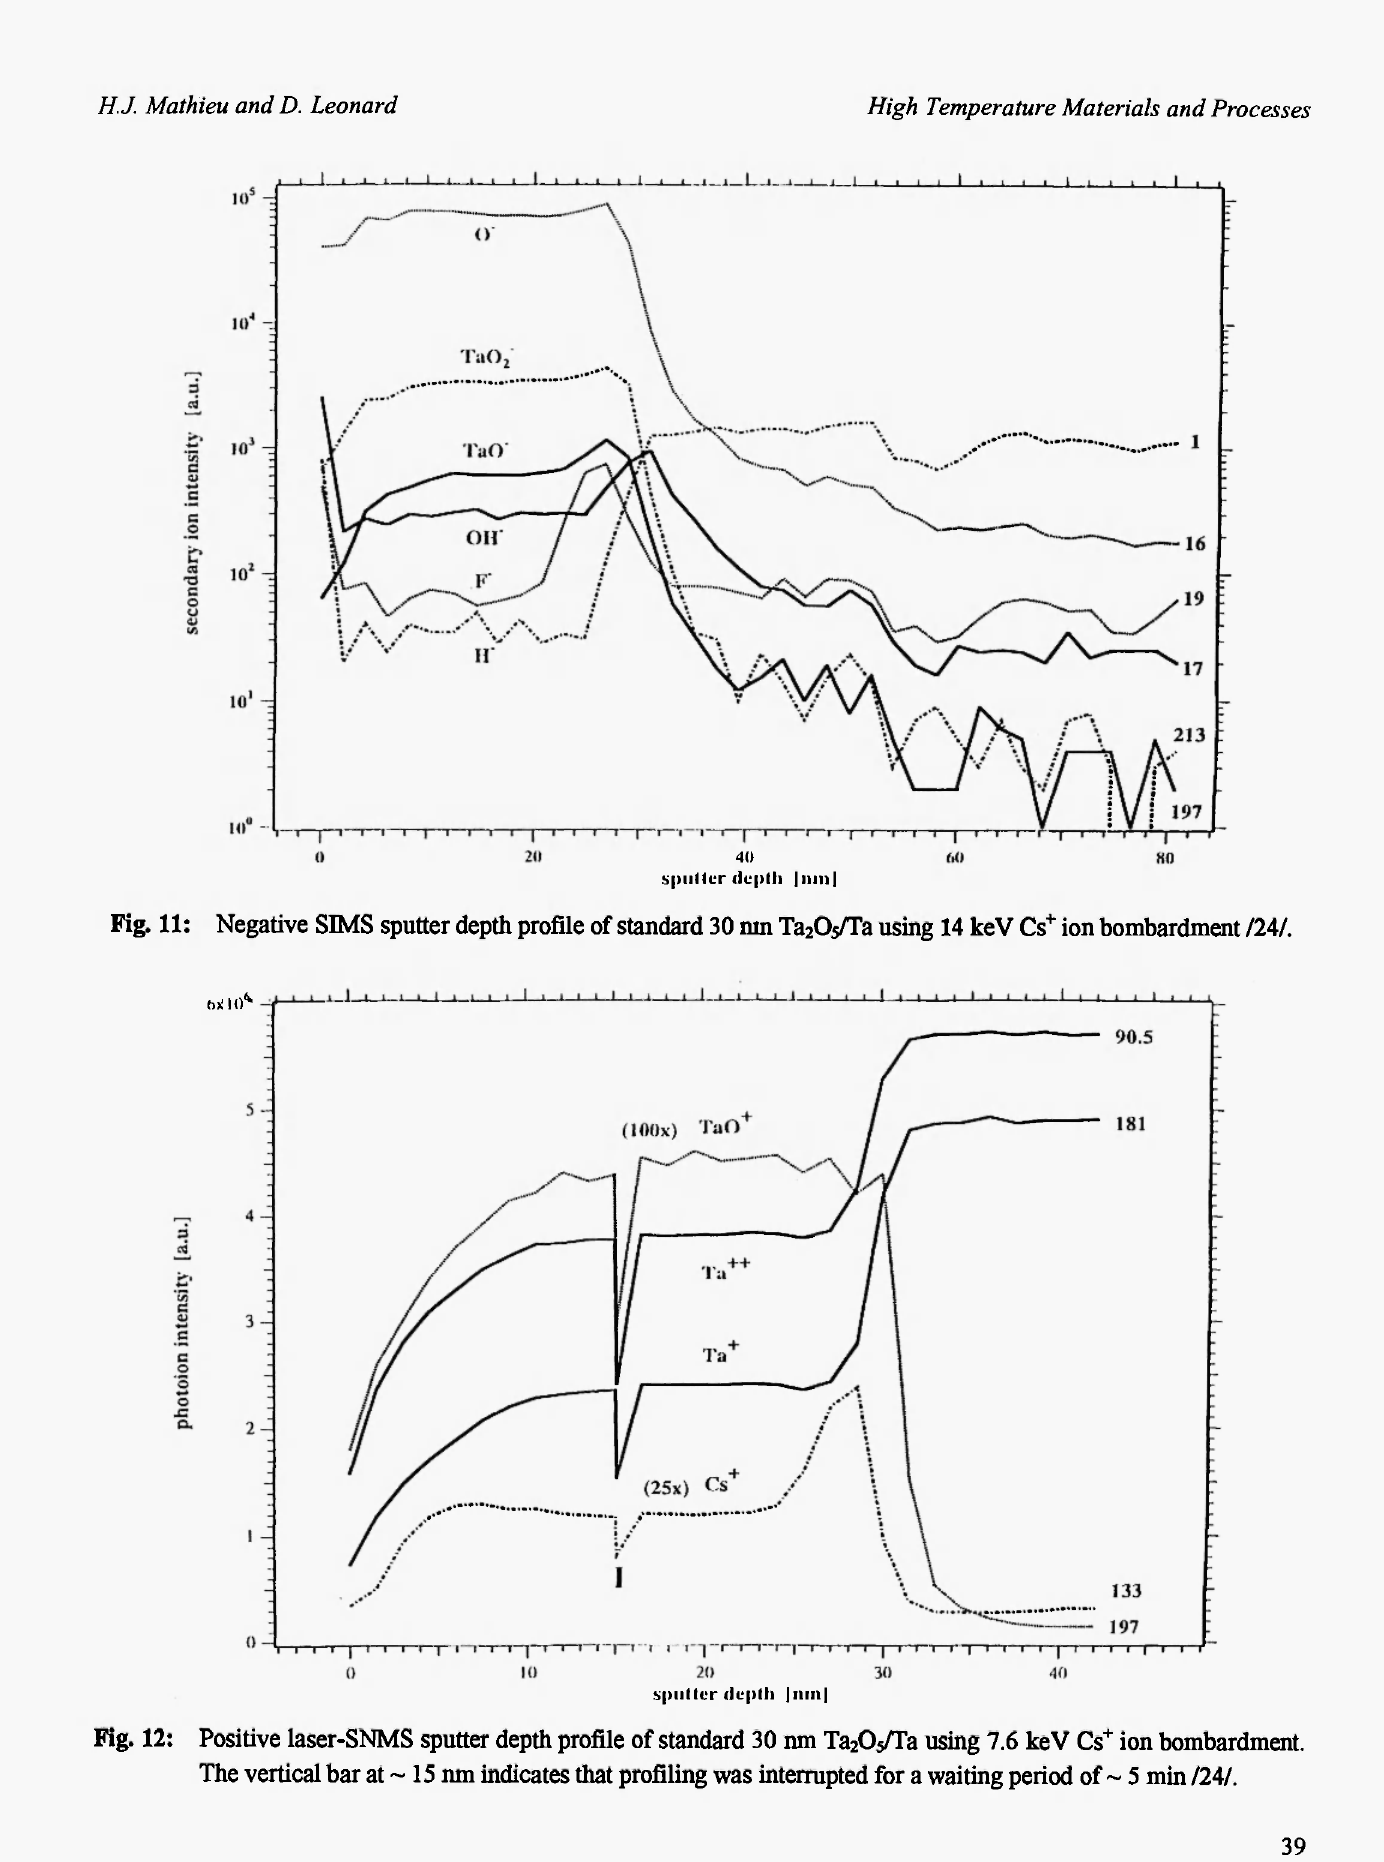
sputter depth |nin| Fig. 12: Positive laser-SNMS sputter depth profile of standard 30 nm Ta 05/Ta using 7.6 keV Cs + ion bombardment. 2 The vertical bar at ~ 15 nm indicates that profiling was interrupted for a waiting period of ~ 5 min /24/.